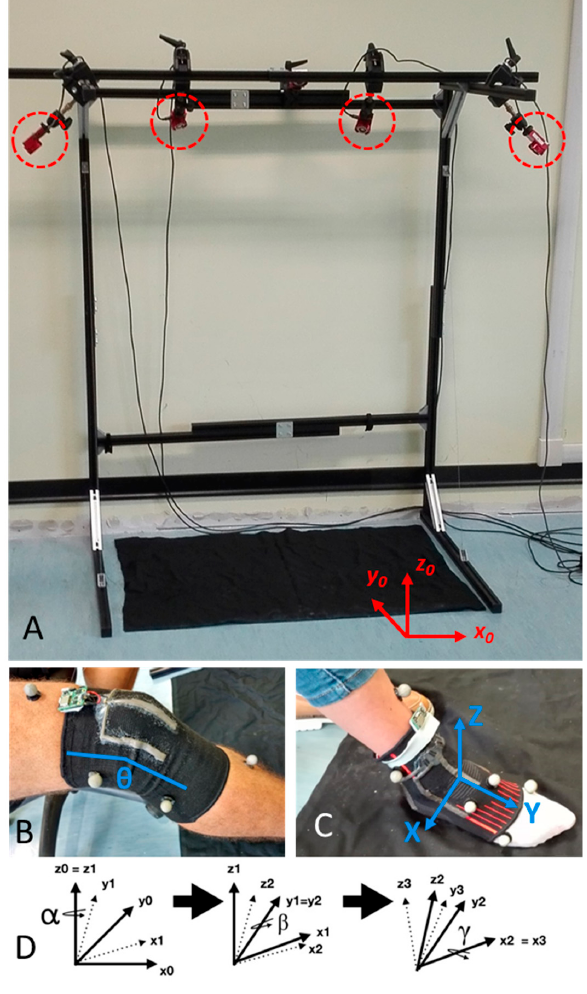
Figure 6. ( A ) Optitrack system used for experimental characterization. In red circles the four cameras of the system. The x 0 - y 0 - z 0 fixed reference system is displayed in red. ( B ) Knee module worn during experiments. Optical markers, attached to the body, are well visible. The knee bending angle θ is labeled in blue. ( C ) Ankle module worn during experiments, with optical markers attached to the body. The moving reference system x - y - z is labeled in blue. ( D ) Euler angles used in the reconstruction algorithms for the determination of joint rotations.